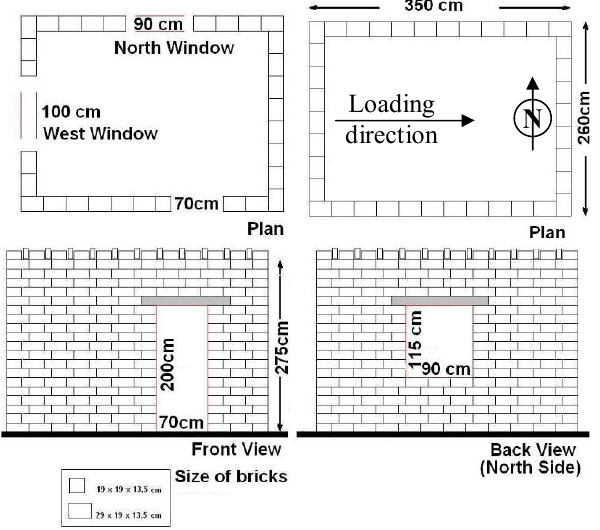
Fig. 6 Geometry of model house Fig. 6. Geometry of model house.